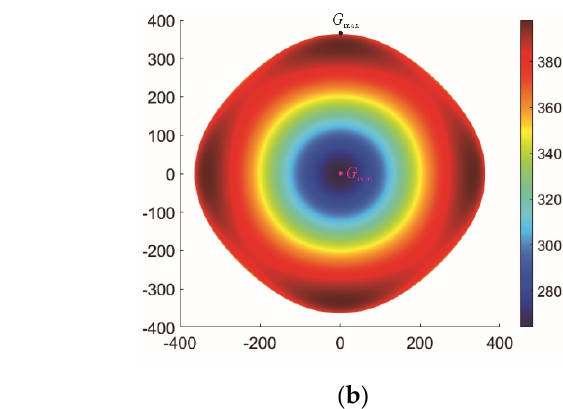
Figure 3. Elastic modulus of Mo 5 SiB 2 single crystals: ( a ) 3D diagram; ( b ) isosurface map. The shear modulus of the Mo 5 SiB 2 single crystals in each direction in the lattice was related to l vector and m vector, and the shear modulus G in any direction in space was expressed as follows